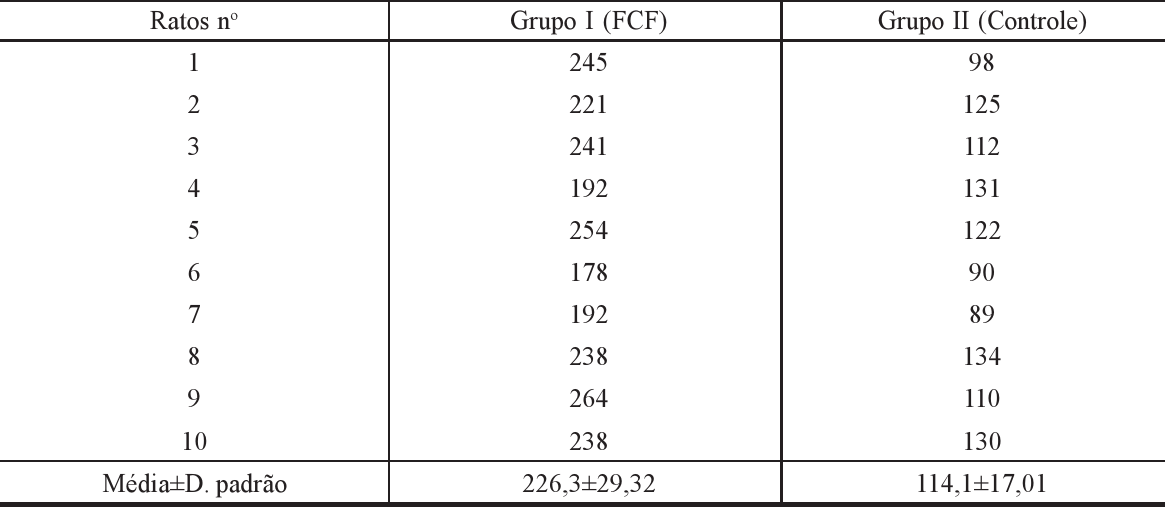
Tabela 2- Densidade mØdia dos elementos histopatol(cid:243)gicos observados nos dois grupos de acordo com a quantifica(cid:231)ªo